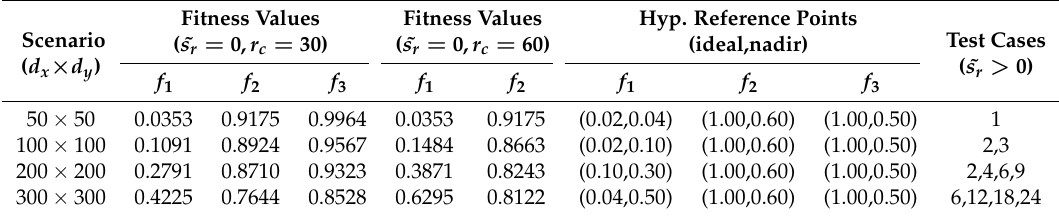
Table 1. Dataset description.